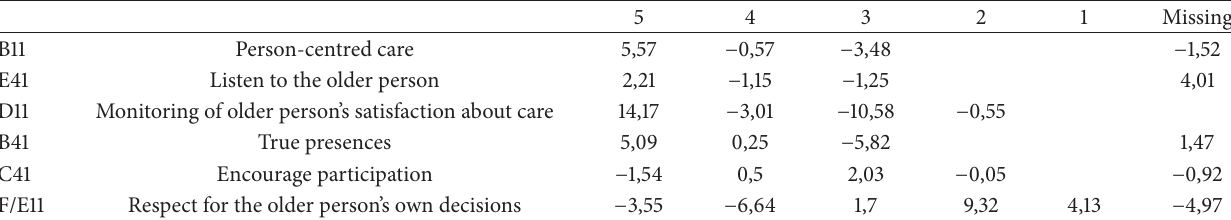
Table 18: Effects on distribution function when C11 “4” =